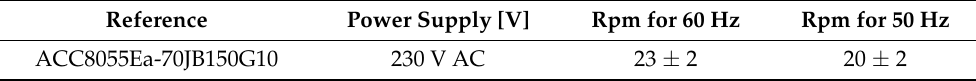
Table 5. Characteristics of the punching motor.